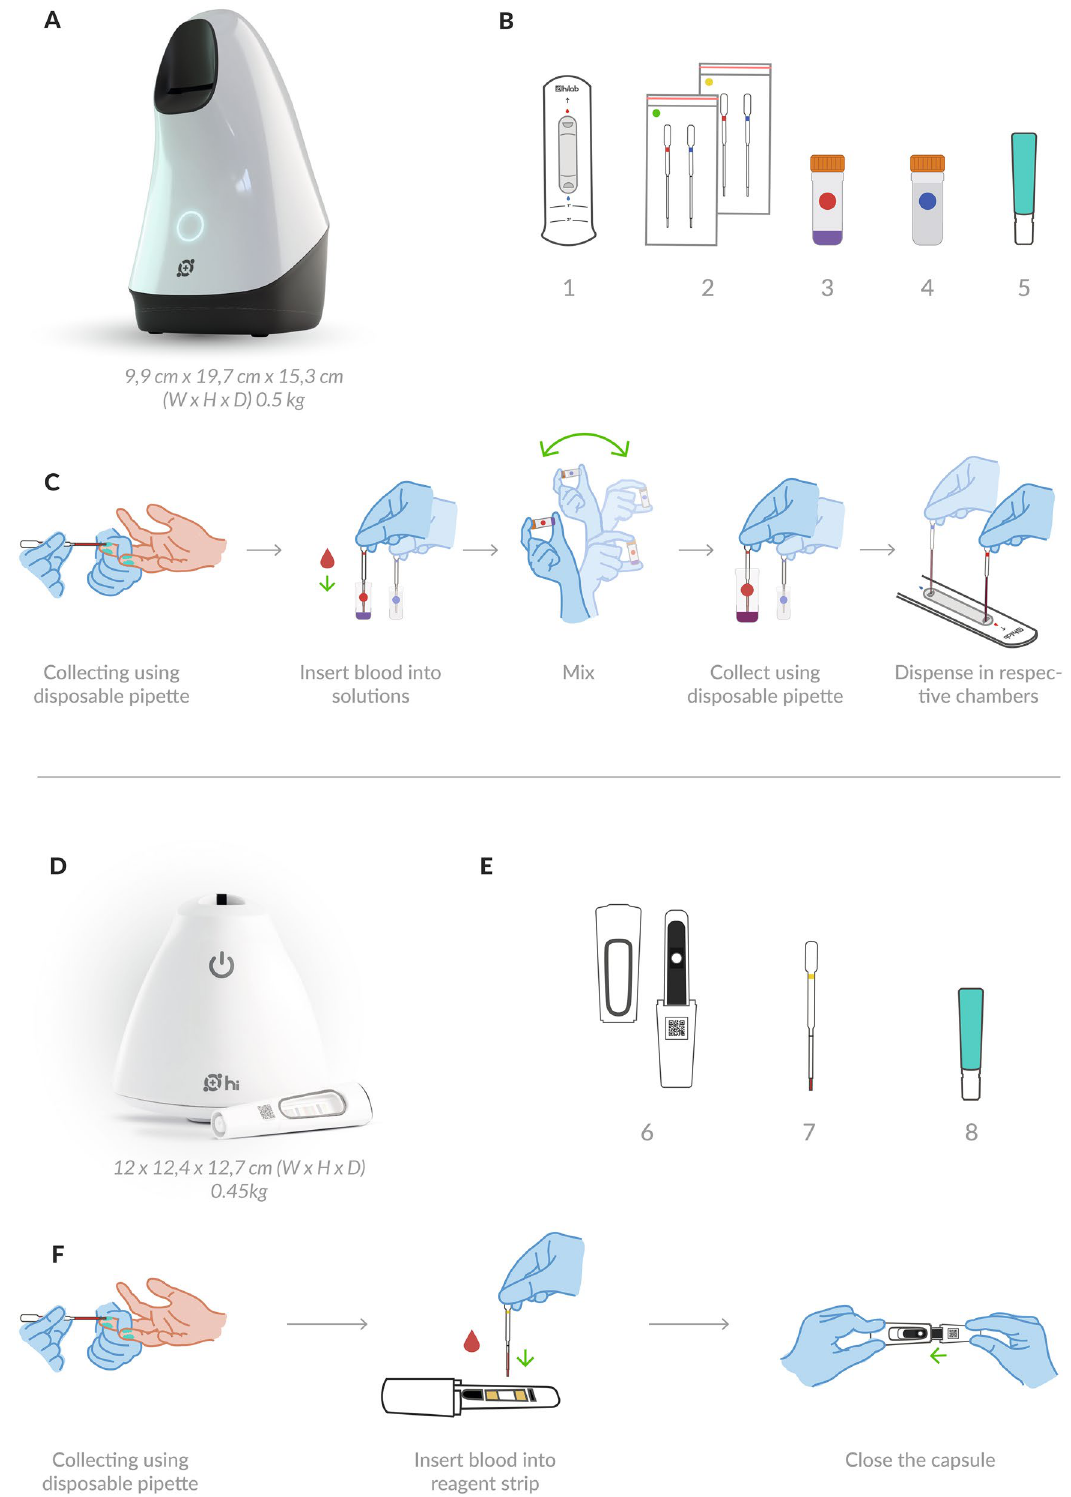
Figure 1. The Hilab system POCT hematology analyzer. Panel ( A ) shows Hilab lens device representation (Hilab, Brazil). ( B ) Components of the Hilab Lens test kit: (1) Hemocytometer, (2) Blood collection pipettes and Blood transfer pipettes, (3) Mixing-bottle of diluent 1; (4) Mixing-bottle of diluent 2; (5) Lancet. ( C ) Hilab Lens sample preparation workflow for capillary samples. Panel ( D ) shows the Hilab Flow device representation (Hilab, Brazil). ( E ) Components of the Hilab Flow test kit: (6) Capsule; (7) Blood collection pipette; (8) Lancet. ( F ) Hilab Flow sample preparation workflow for capillary samples. Both single-use test kits accompany isopropyl alcohol swab and curative. ( G ) Hilab’s software examples of evaluated blood